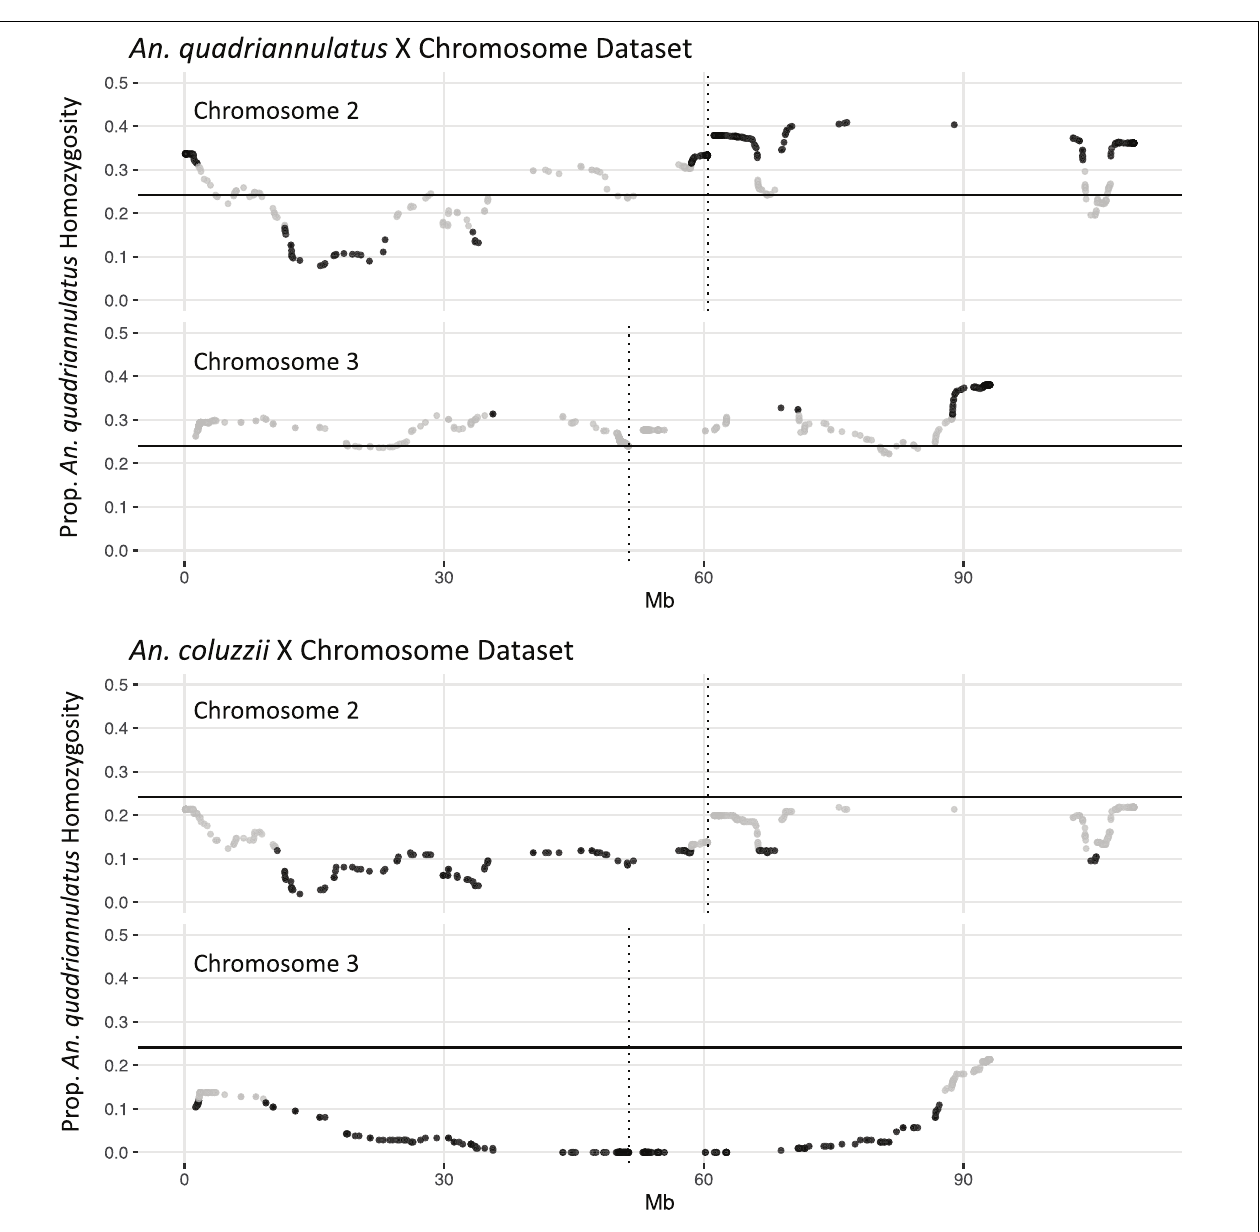
FIGURE 2 | Segregation distortion at chromosome 2 and 3 loci for the An. quadriannulatus X chromosome (top) and An. coluzii X chromosome dataset (bottom). Gray dots indicate SNPs that do not deviate significantly from the expected proportion of homozygosity (solid horizontal line), while black dots deviate significantly (chi-square p < 0.05). Vertical dotted lines indicate centromere